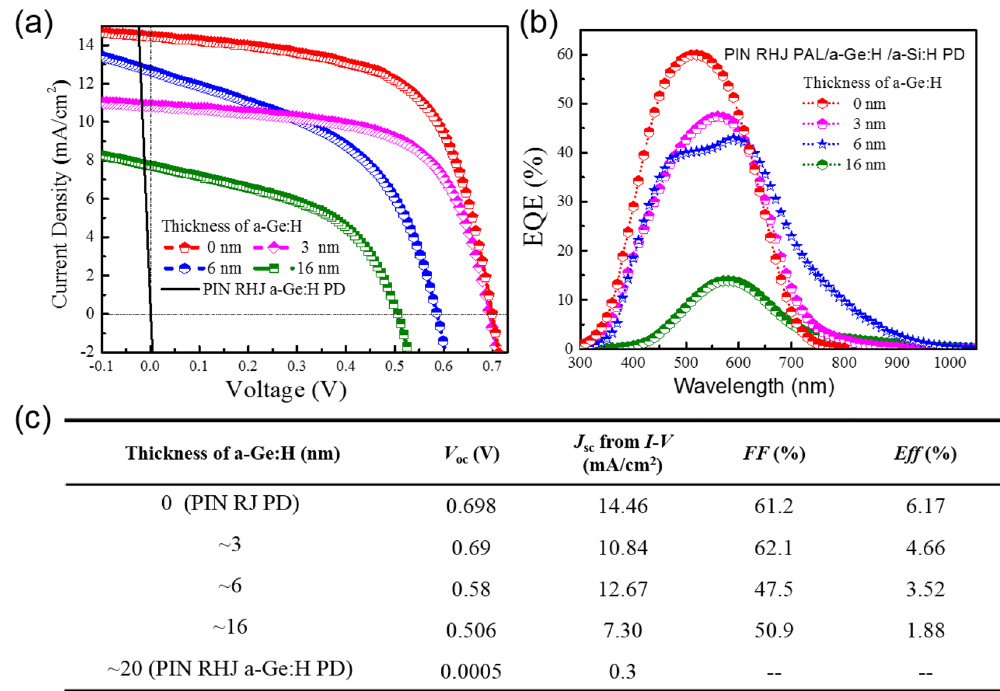
Figure 3. ( a – c ) Show the current density-voltage (J-V), EQE curves and performance parameters of PIN RHJ PAL/a-Ge:H/a-Si:H PD with different a-Ge:H thicknesses when fixed the PAL thickness at ~35